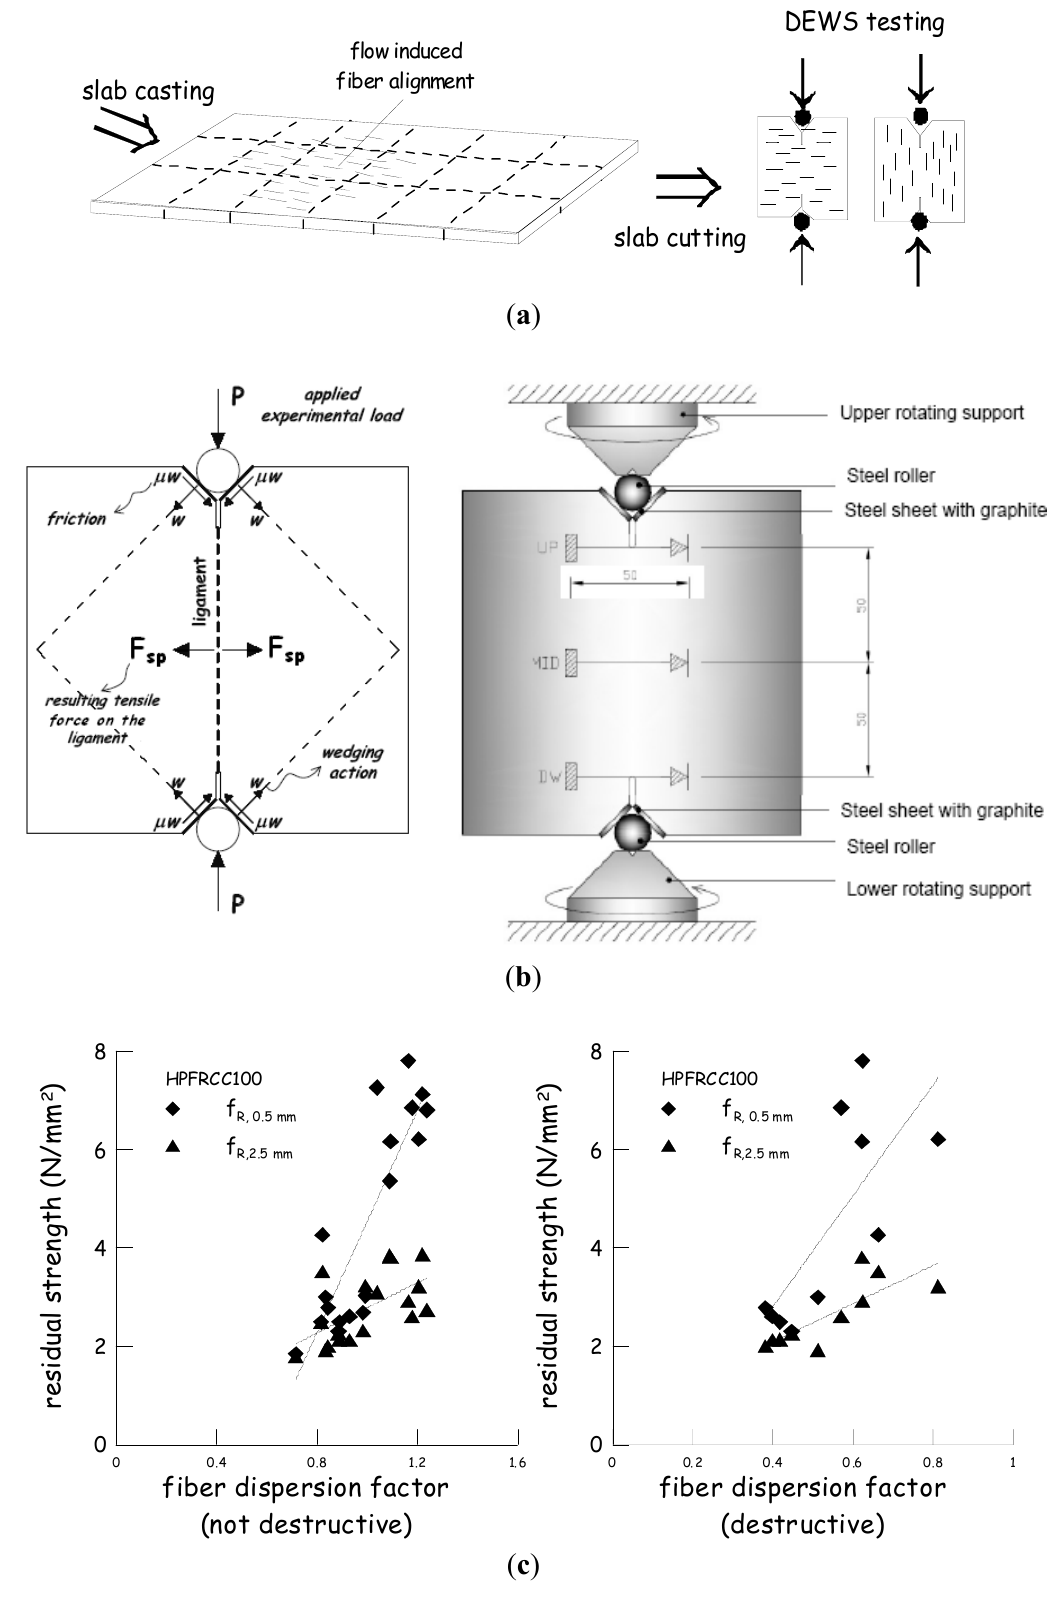
Figure 10. Schematic of slab casting and specimen cutting for Double Edge Wedge Splitting (DEWS) test ( a ); specimen geometry and test set-up ( b ); residual stresses vs. fiber orientation/dispersion factor ( c